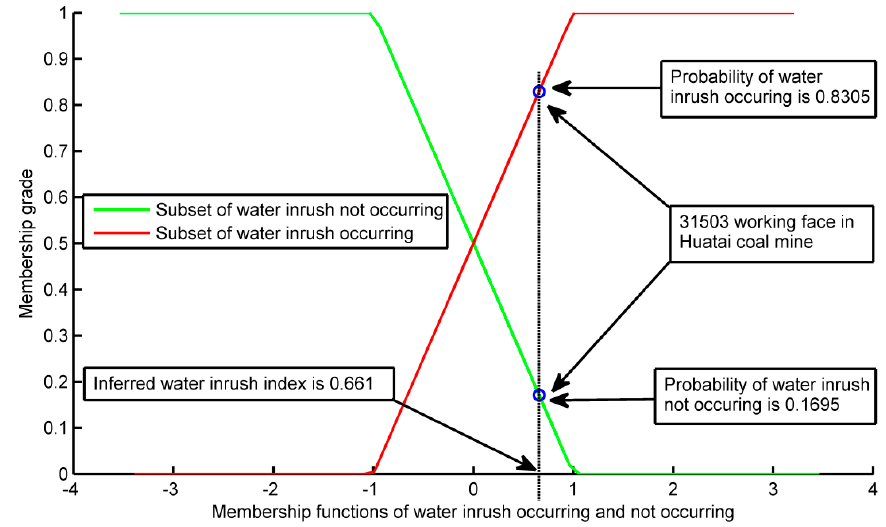
Figure 11. Membership functions of water inrush occurring and not occurring; how to use the water inrush index to obtain the probabilities of water inrush occurring or not occurring is also displayed in this figure.